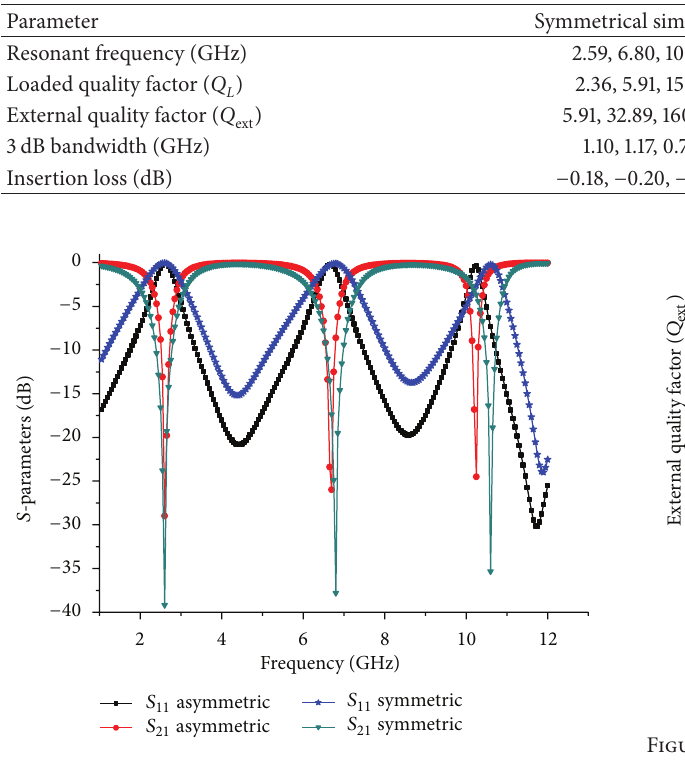
Figure 5: Simulated results of the symmetric and asymmetric TBBSFs.